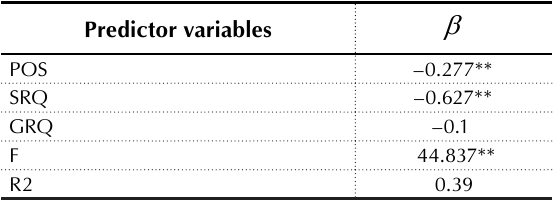
Table 2. Regression results predicting expected